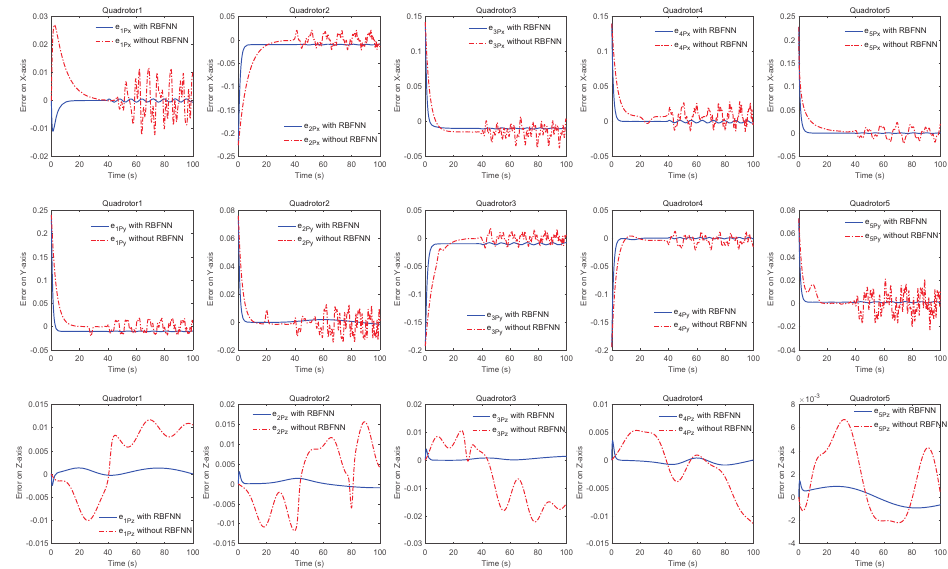
Figure 6. Comparison of position tracking errors with and without radial basis function neural network (RBFNN).